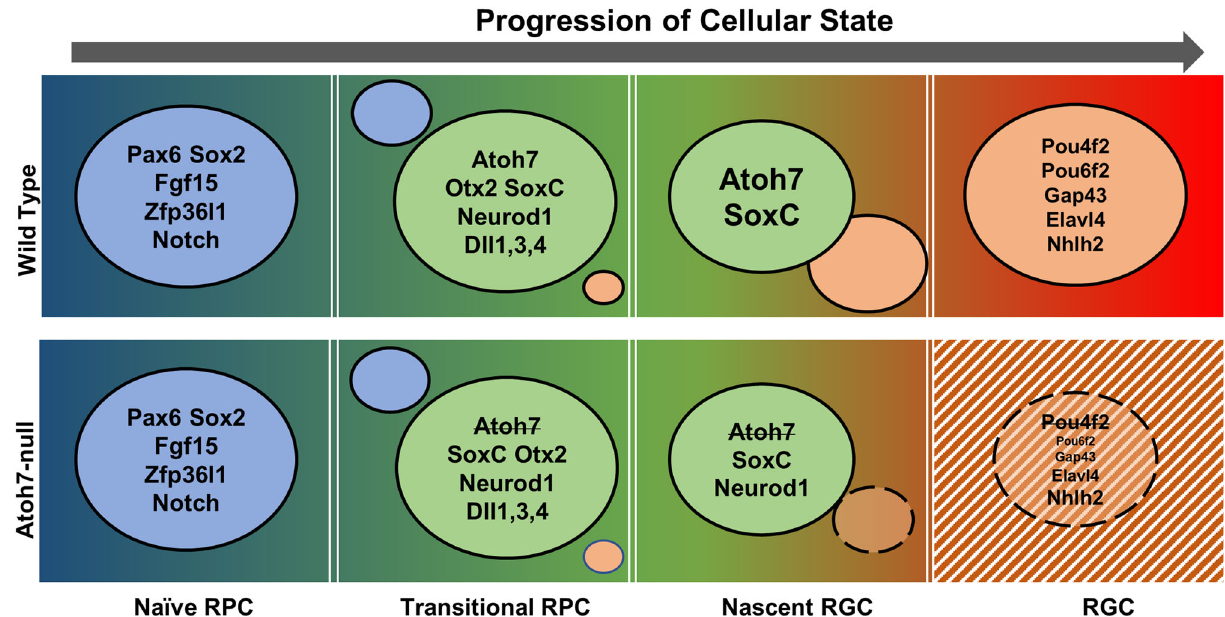
Fig. 10 A model explaining shifts of cell states along the RGC trajectory in the wild-type and Atoh7 -null retina. The RGC trajectory follows four cell states, including naive RPCs, transitional RPCs, nascent RGCs, and differentiated RGCs. The direction of the trajectory is indicated by the arrow and the progression of the trajectory is indicated by a color gradient. Each state is determined by a group of genes and example genes are given in colored circles. The transition from one state to the next is dictated by the downregulation of genes representing that state and upregulation of genes for the next state as indicated by the sizes of the colored circles. In the transitional RPCs, Atoh7, likely in combination with the SoxC factors, competes with other regulators to drive them to the RGC fate. In the Atoh7 -null retina, the establishment of the transitional RPC state is not affected, and nascent RGCs still form through the expression of some, but not all, RGC genes (represented by a smaller circle with broken lines). The mutant nascent RGCs fail to reach the full RGC state and many eventually die by apoptosis (indicated by a striped